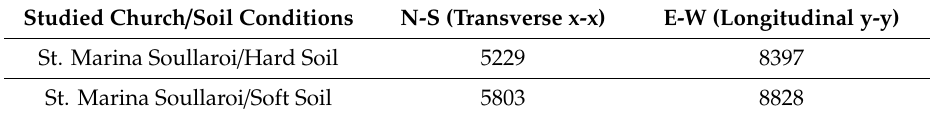
Table 3. Base shear Values (KN) based on the Chavriata response spectra (which is the most demanding). Studied Church / Soil Conditions